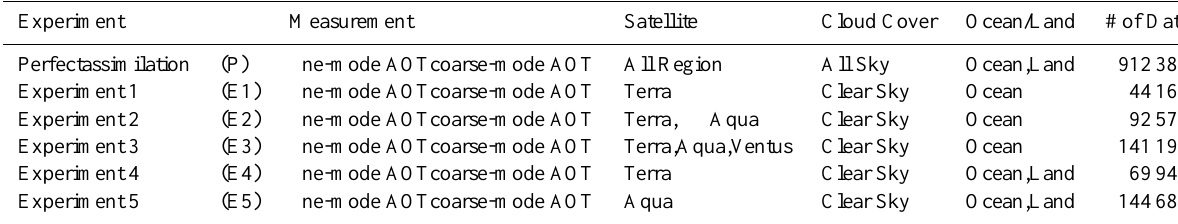
Table 5. Inversion experiments and their settings.